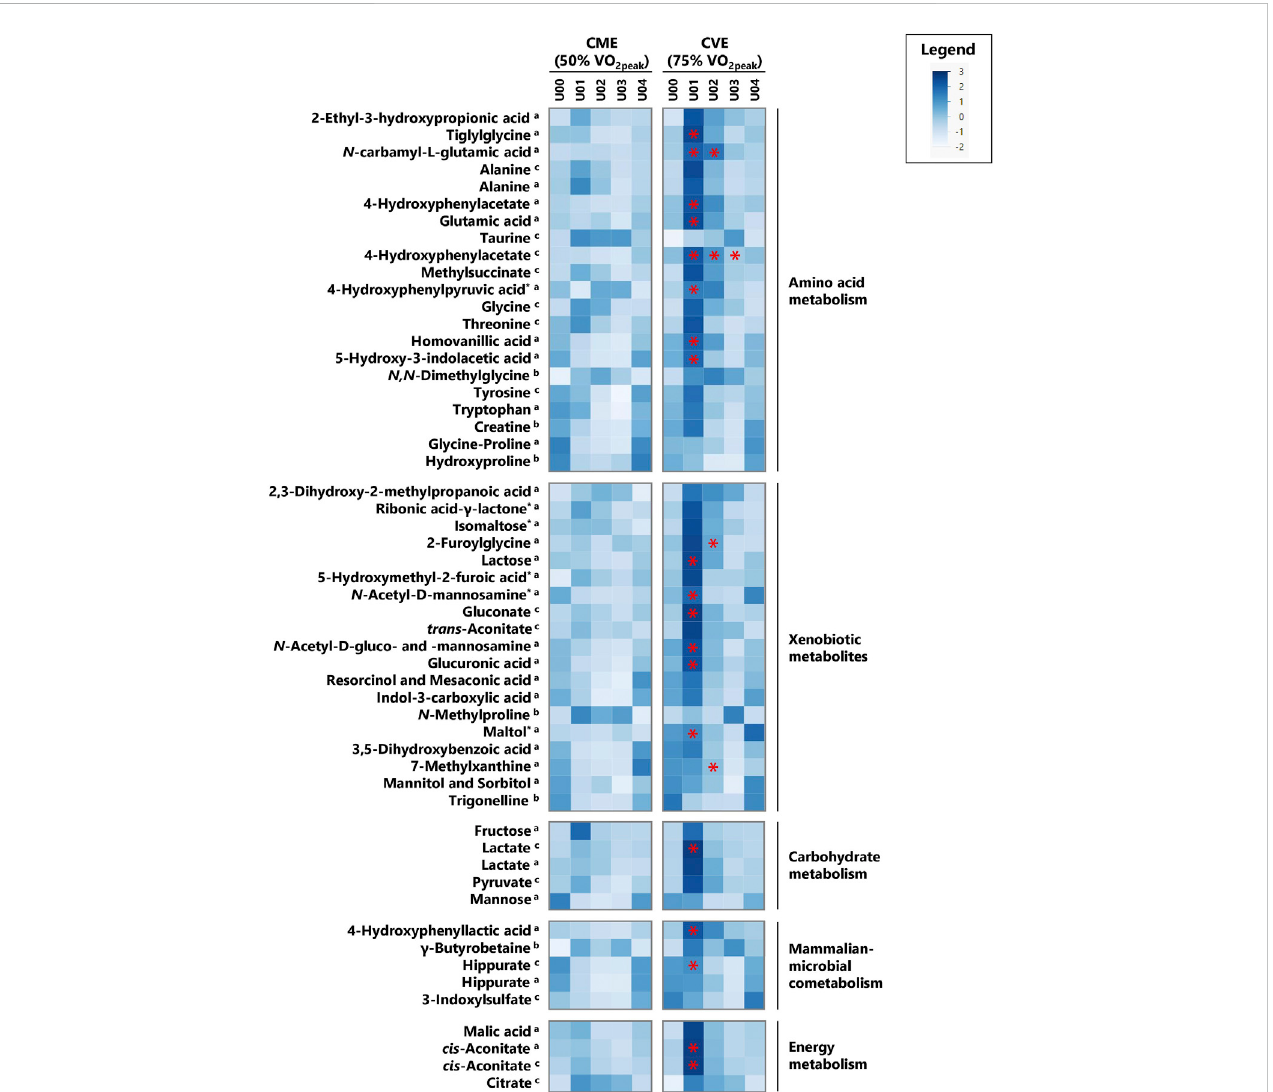
Heatmapof z -transformedmedianconcentrationsorsignalintensitiesperurinesampletimepointintheCMEandCVEtrialfor exercise-responsive and/ or intensity-dependent metabolites, sorted by most relevant major metabolic pathways/classes and decreasing median FCs for U01 (CVE)/U00 (CVE) ratio. Metabolites with relevant differences between interventions are indicated with a red asterisk. a : GC×GC-MS-detected; b : LC-MS-detected; c : NMR-detected; *: evaluated based on heuristic/visual approach; U: unknown